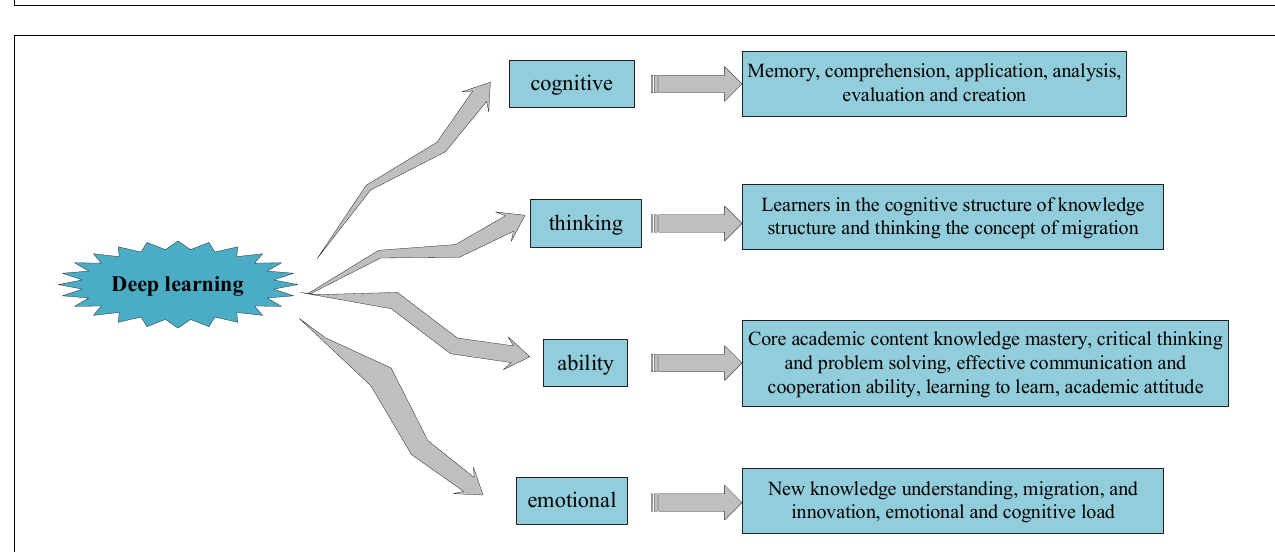
FIGURE 1 | Comparison of deep learning (DL) and superficial learning.